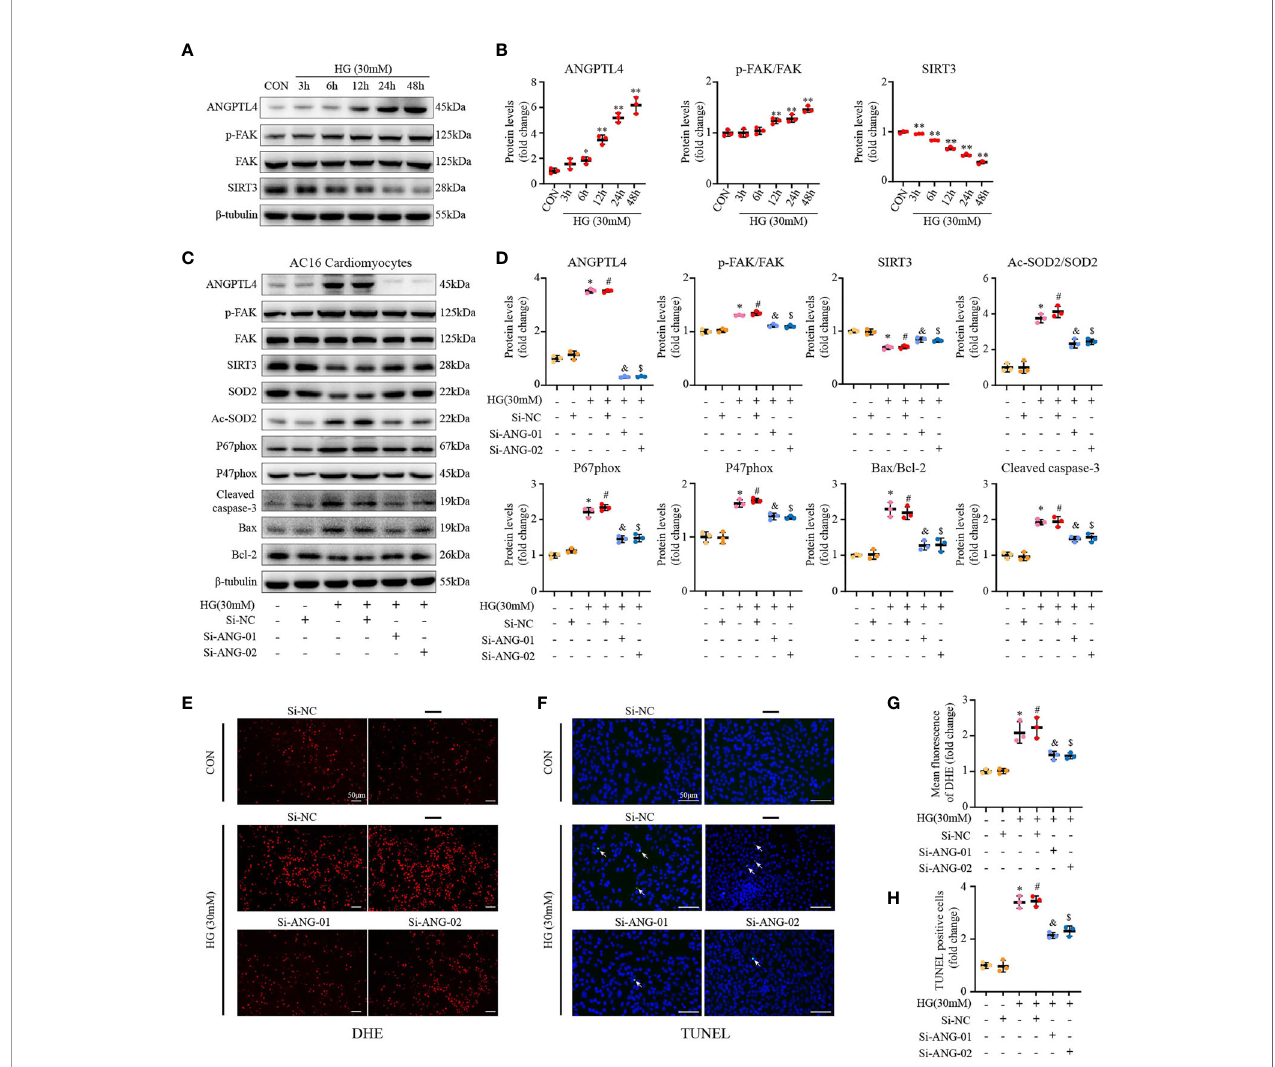
FIGURE 7 | ANGPTL4 siRNA exhibited the anti-apoptotic and anti-oxidative effects in HG-treated AC16 cardiomyocytes. (A) Representative Western blots showing ANGPTL4, p-FAK(Y397), FAK, and SIRT3 levels in AC16 cardiomyocytes at indicated time points after treatment with HG (30 mM). (B) WB analysis of ANGPTL4 expression, p-FAK(Y397)/FAK ratio, and SIRT3 expression at indicated time points, respectively. (C, D) Representative Western blots and quanti fi cation of p-FAK(Y397), FAK, SIRT3, Ac-SOD2, SOD2, P67phox, P47phox, Cleaved caspase-3, Bcl-2, and Bax in cultured AC16 cardiomyocytes under the control or HG (30 mM) condition plus treatment with si-RNA targeting ANGPTL4 (si-ANGPTL4) or negative control siRNA (si-NC). Equal protein loading was con fi rmed using an anti- b -tubulin antibody. (E, G) Representative images and quanti fi cation of DHE fl uorescence in cultured AC16 cardiomyocytes under the control or HG (30 mM) condition plus treatment with si- RNA targeting ANGPTL4 (si-ANGPTL4) or negative control siRNA (si-NC). Scale bars, 50 m m. (F, H) Representative images of apoptotic cardiomyocytes (200×) and percentage of TUNEL positive cells. The apoptotic cells were detected by TUNEL (green), and the nuclei were detected by DAPI (blue). Scale bar, 50 m m. Experiments were repeated at least three times independently with similar results. * p < 0.05, ** p < 0.01 vs CON group. # p < 0.05 vs the CON+SiNC group; & p < 0.05 vs the HG +SiNC group; $ p < 0.05 vs the HG+SiNC group (student t